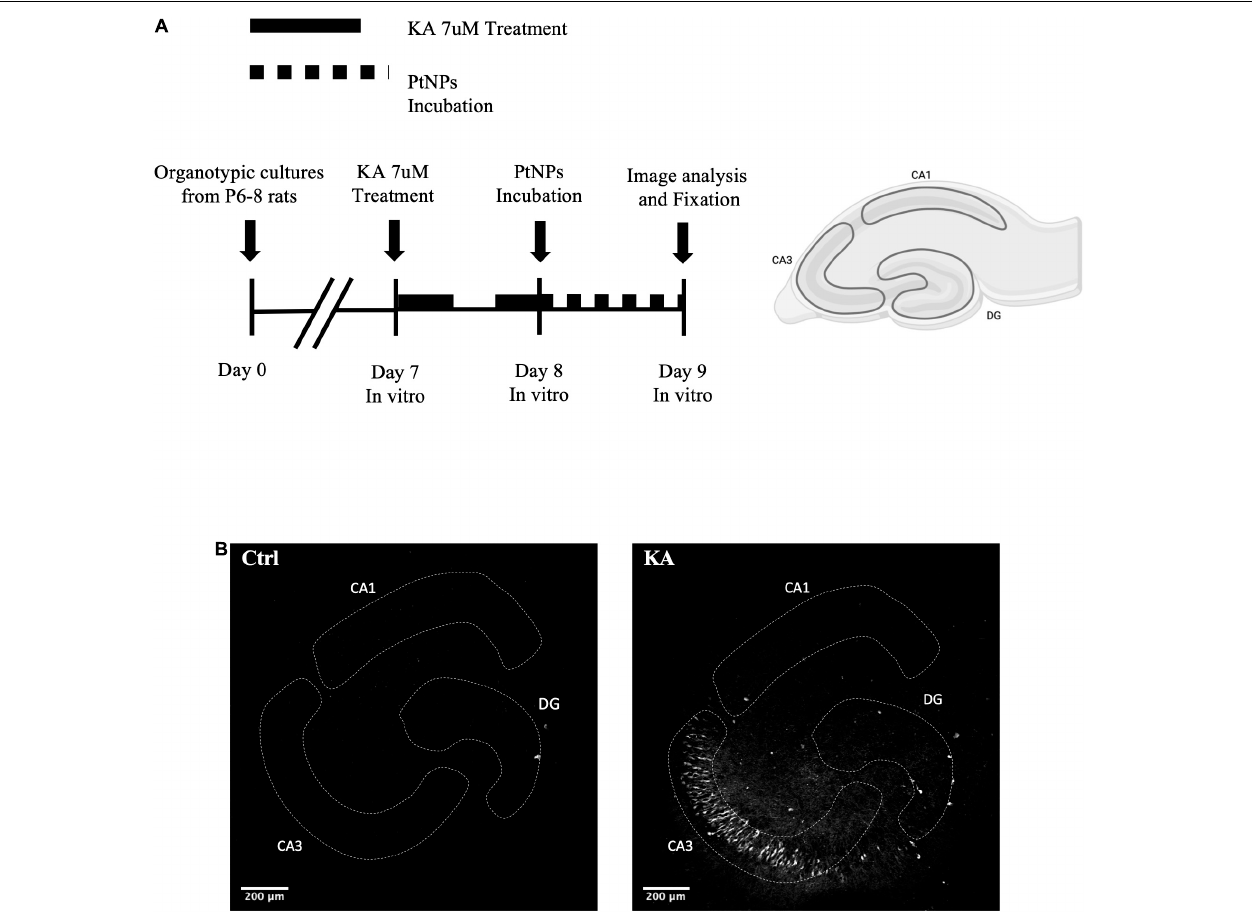
FIGURE 1 | Establishment of rat hippocampal organotypic cultures as a 3D model to study the biocompatibility of Platinum nanoparticles (PtNPs) both in normal and pathological conditions. (A) Experimental scheme for inducing the pathological state and assessing the biocompatibility of PtNPs in the organotypic hippocampal slices. After 7 days in culture, slices are treated with kainic acid (KA) for 24 h followed by a 24-h incubation period with PtNPs. (B) Representative Fluoro-jade C staining of degenerating neurons in organotypic hippocampal slices under control condition and KA 7 uM at day 8 in vitro .